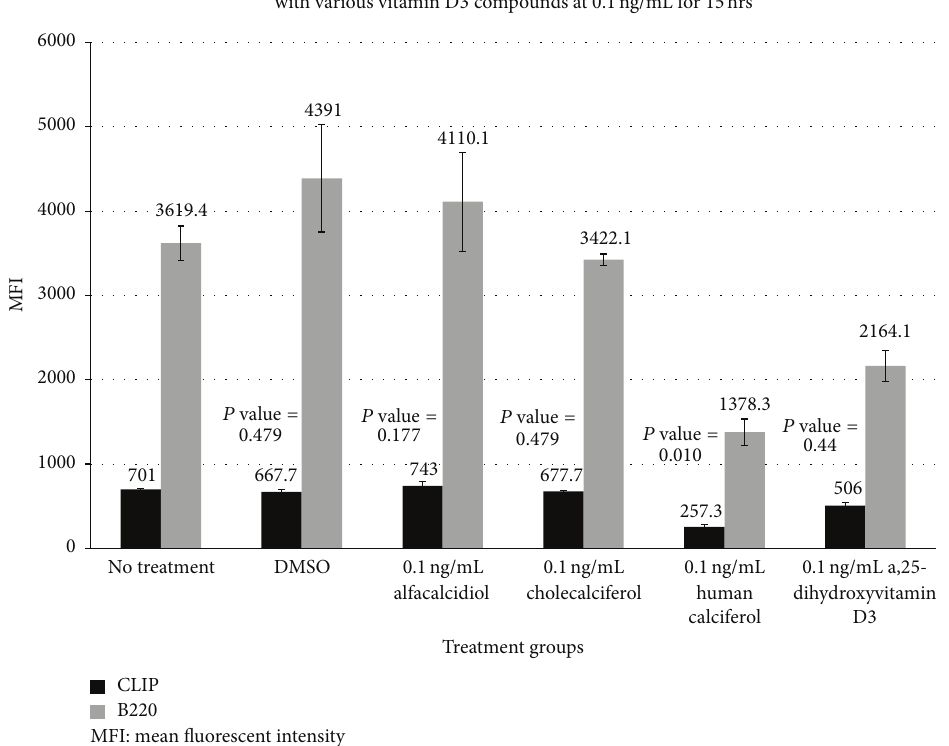
Figure 1: This bar graph shows the effects of various vitamin D3 compounds at a low concentration of 0.1 ng/mL on the mean fluorescent intensity (MFI) of CLIP + B cells after TLR-engagement. This figure demonstrates the changes in MFI of CLIP and CLIP + B220 subsets of B cells after CpG-induced TLR-9 activation. These results suggest that the active formulation of vitamin D3 may lead to a statistically significant reduction in CLIP expression on polyclonally activated splenic B cells. Administration of the human calcitriol of vitamin D3 ( 𝑃 = 0.01 ) resulted in the greatest overall reduction in the MFI (257 versus a baseline of 701.1) for CLIP expression on stimulated B